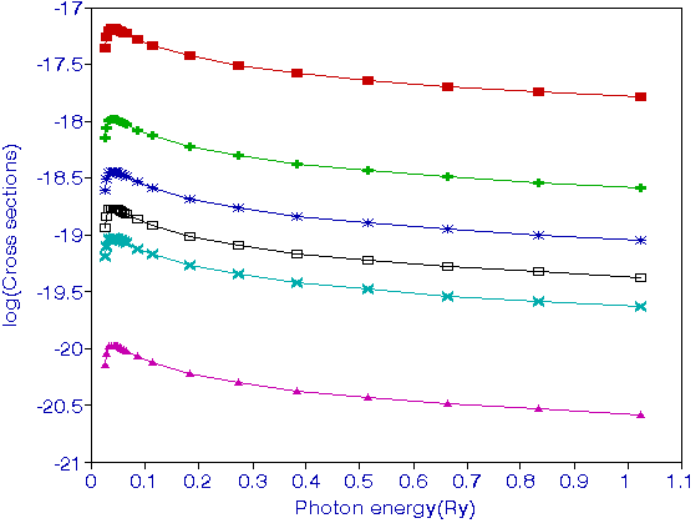
Figure 1. (Color online) The upper most curve represents photodetachment cross sections (units cm 2 ) on a log 10 scale for n = 2. The curves below it are for n = 3, 4, 5, 6, and 7, also on a log 10